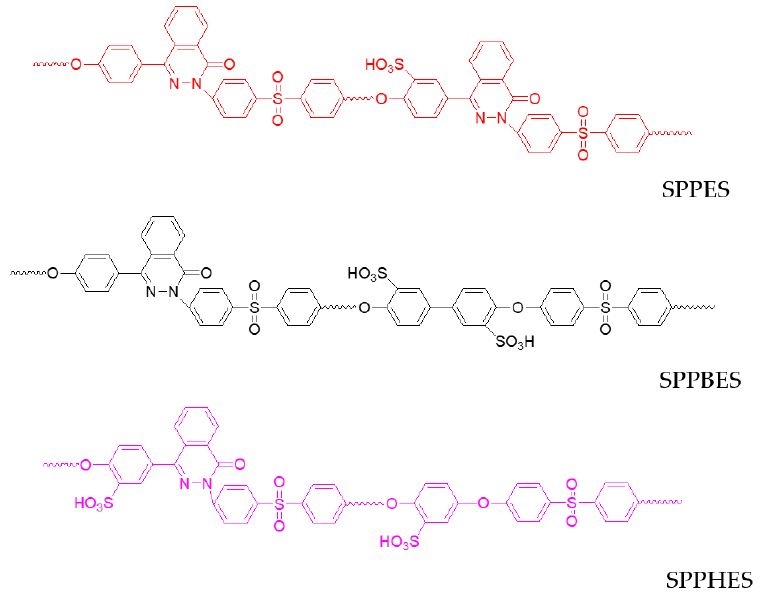
Figure 1. The chemical structure of three sulfonated poly(aryl ether sulfone)s: sulfonated poly(phthalazinone ether sulfone) (SPPES), sulfonated poly(phthalazinone biphenyl ether sulfone) (SPPBES), and sulfonated poly(phthalazinone hydroquinone ether sulfone)s (SPPHES).